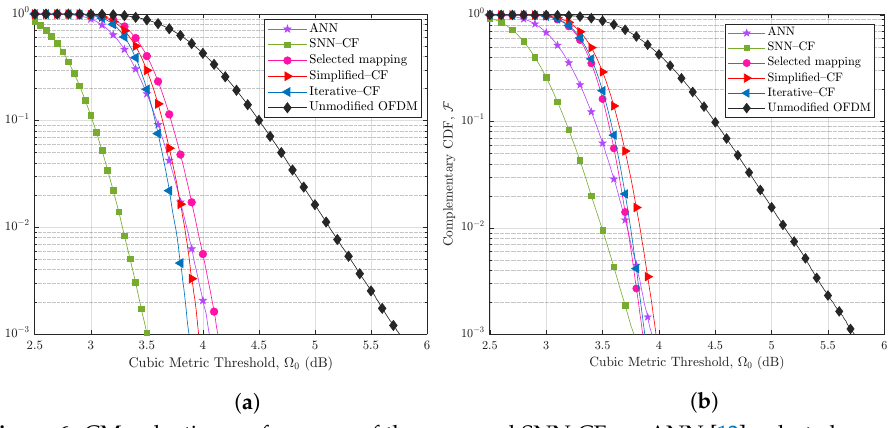
Figure 6. CM reduction performance of the proposed SNN-CF vs. ANN [12], selected mapping [4], simplified-CF [8], iterative-CF [5], and unmodified OFDM for ( a ) QPSK-OFDM, and ( b )